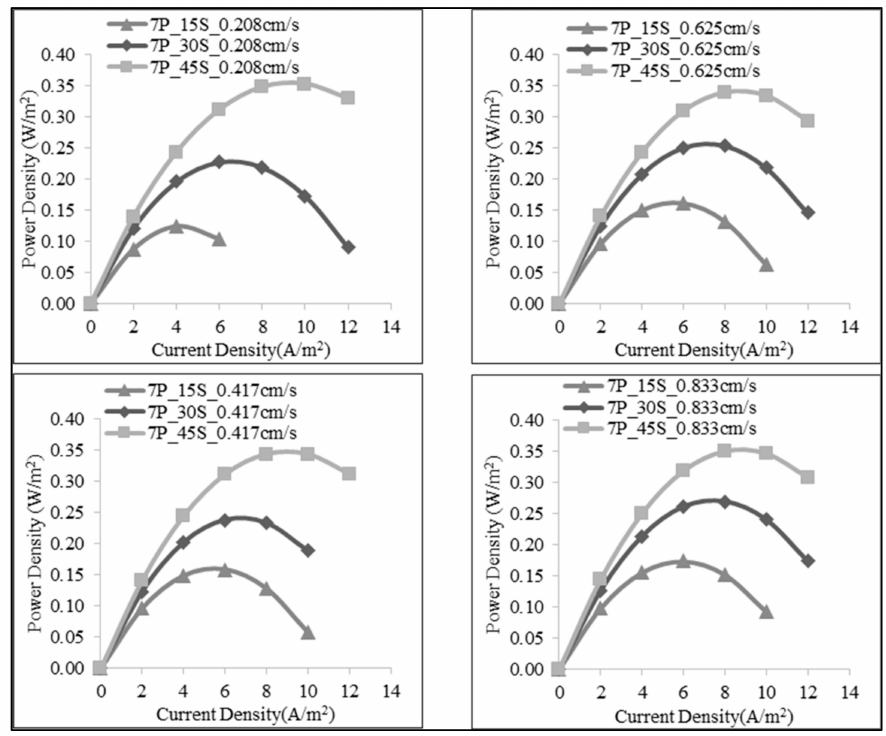
Figure 9. The effect of the salt ratio of feed solutions on power density for 7 membrane pairs. (XP_YS_Zcm/s indicates X membrane pair, Y salt content of HSS and Z feed